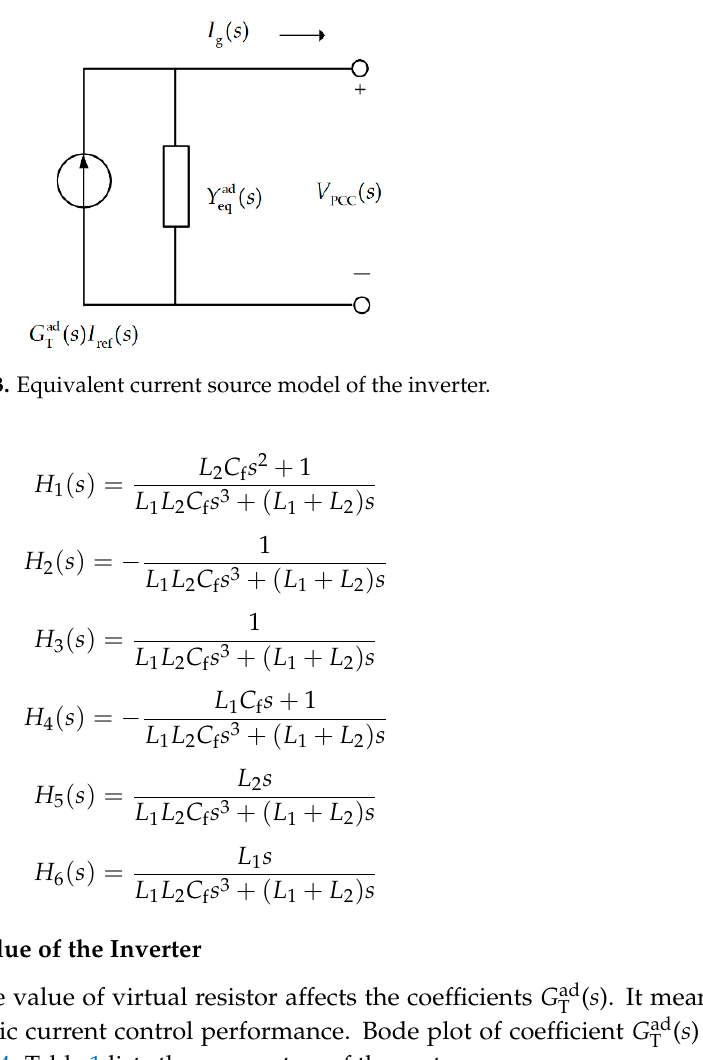
Figure 4. Bode plot of G ad T (s) with different virtual resistor.